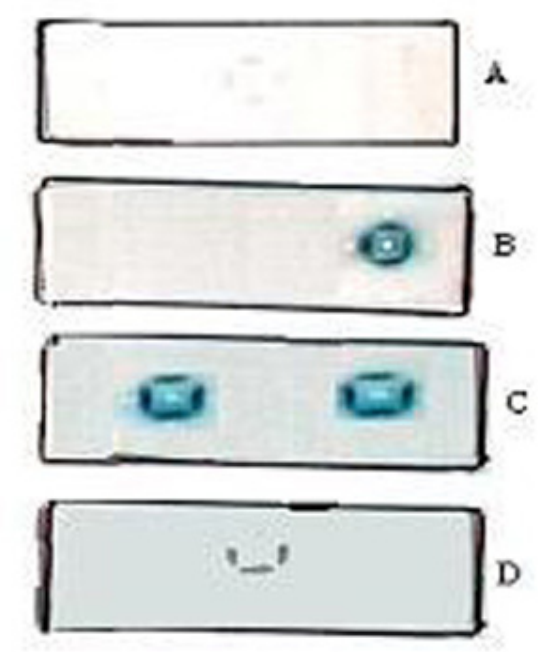
Figure 1. Isolated immunoglobulins from rabbit sera (central well) were incubated in agar gel with photooxidized Vespa orientalis venom at different time intervals of UV exposure: ( A ) 15 minutes, ( B ) 30 minutes, ( C ) 45 minutes, and ( D ) 60 minutes. In ( C ) prominent precipitin lines indicate antigencity.